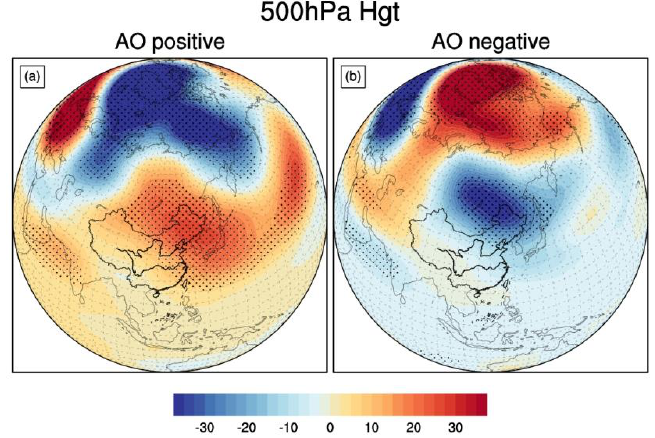
Figure 7. The same as Figure 5, but for the geopotential height field at 500 hPa (unit: gpm). Dots represent the values above the 90% confidence level.